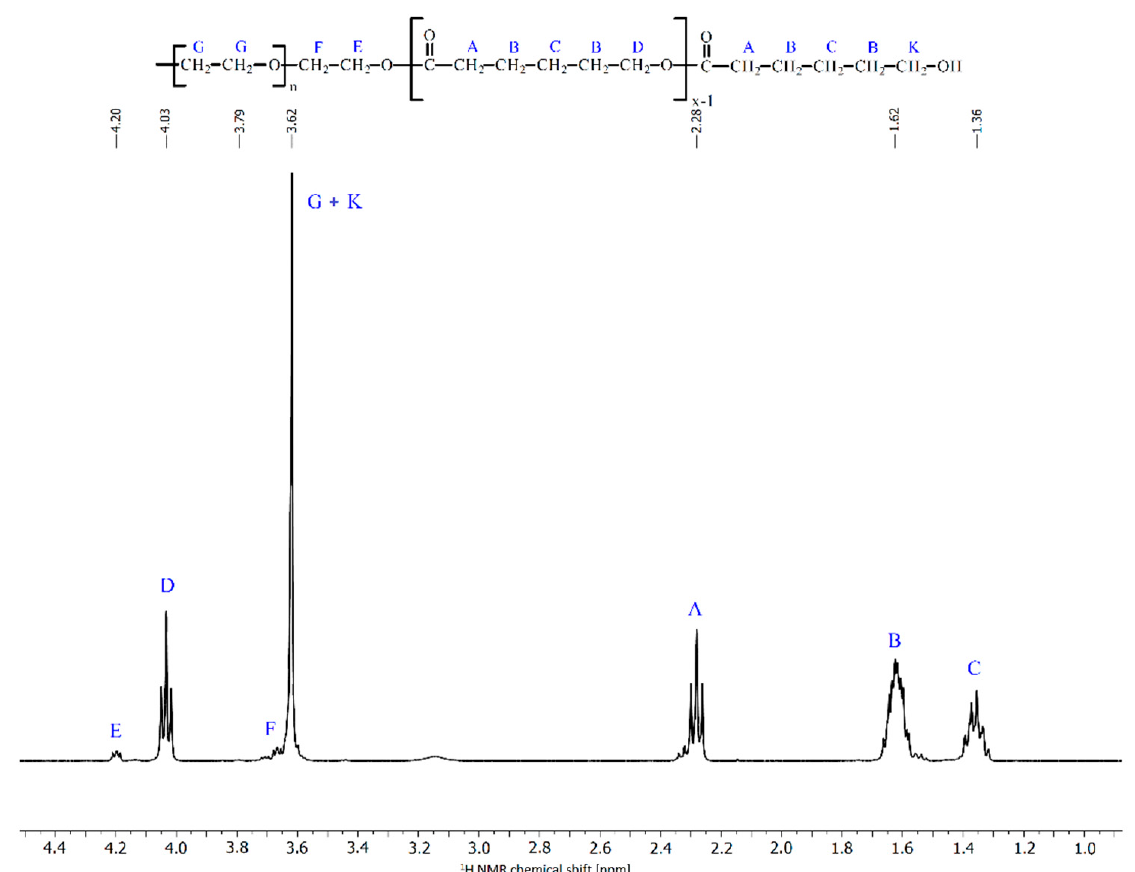
Figure 1. 1 H NMR spectrum of PCEC triblock copolymer.